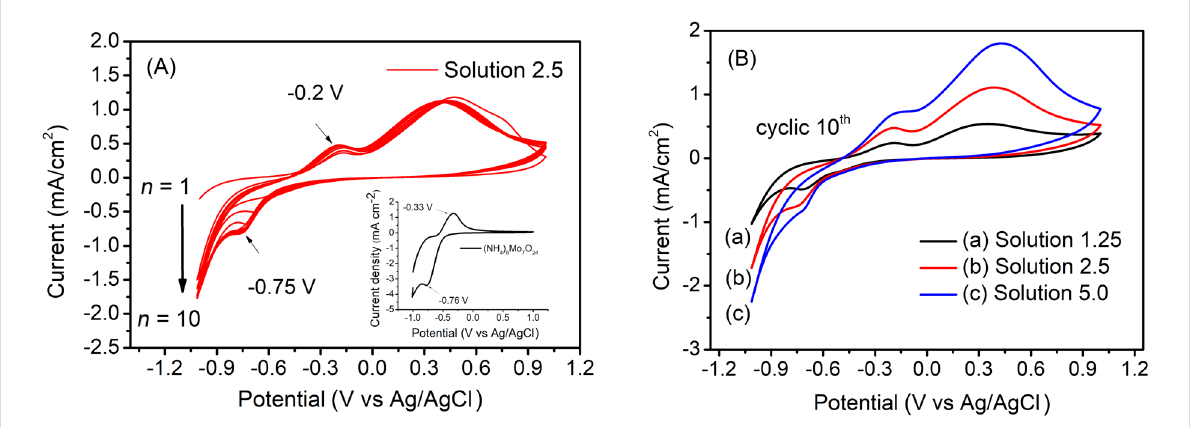
Figure 2: (a) CVs recorded during electrodeposition of MoS 2 from solution 1.25; (b) comparison of the tenth cycle of CVs recorded in solutions 1.25, 2.5, and 5.0; a scan rate of 100 mV·s − 1 was used.